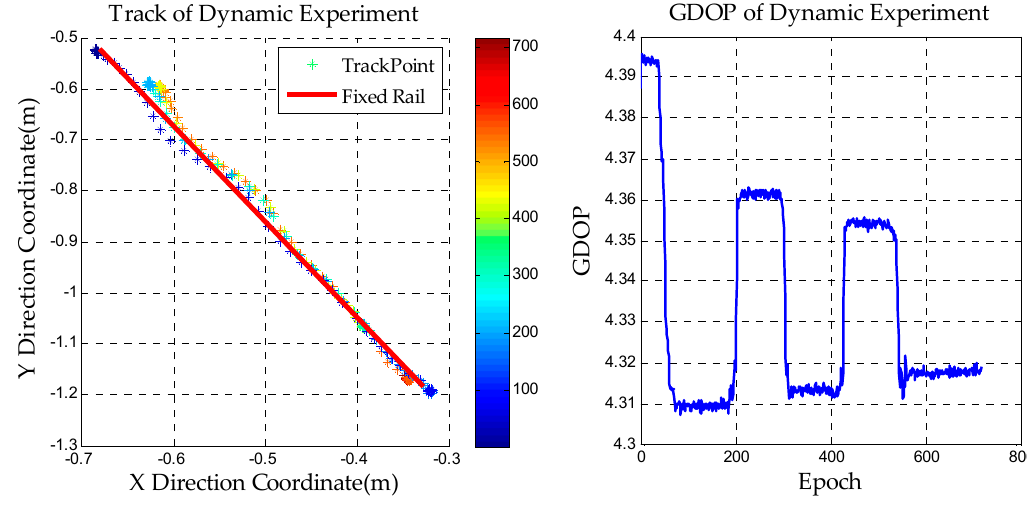
Figure 11. The results of the dynamic experiment.